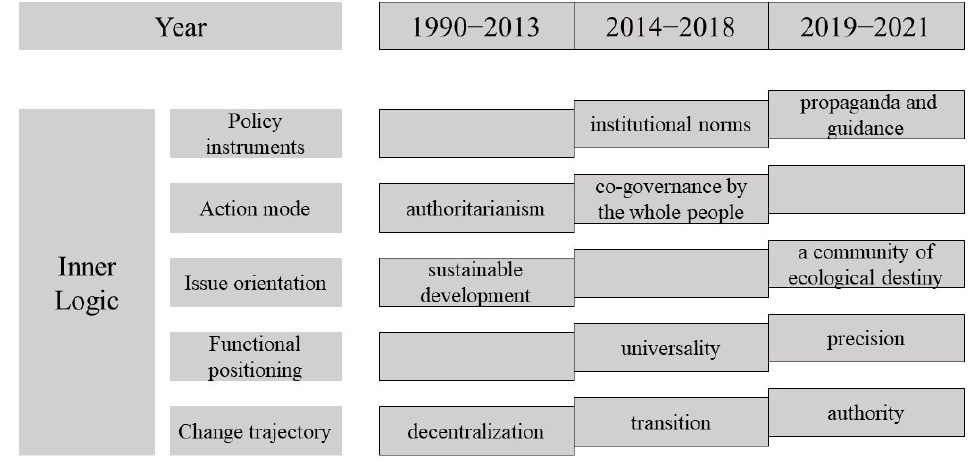
Figure 4. Inner logic diagram of policy carding.